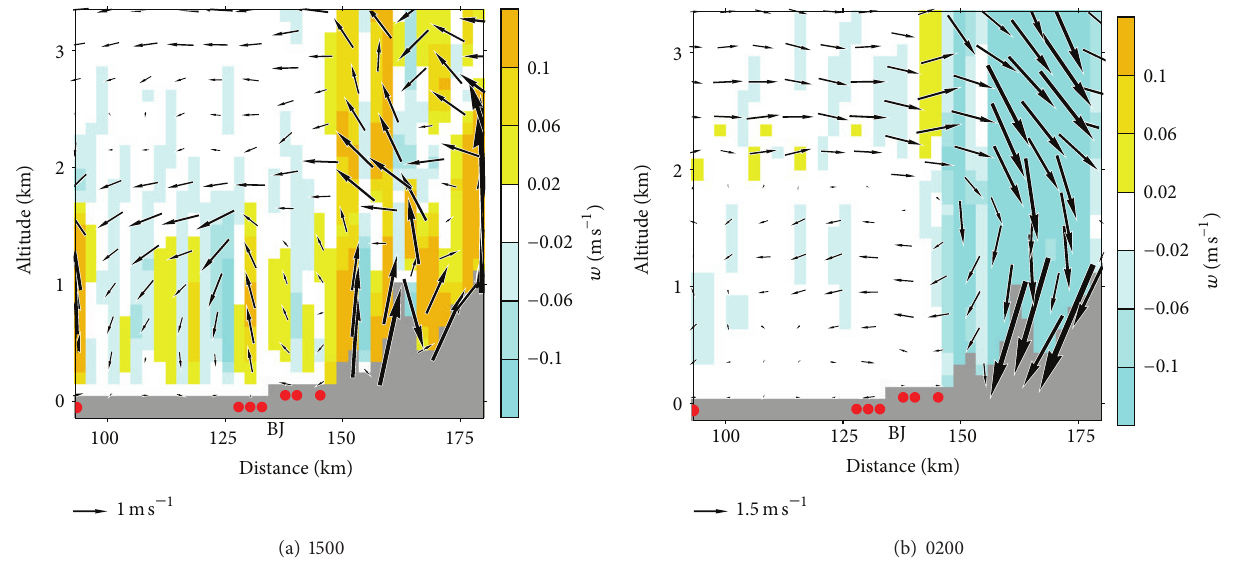
Figure 13: Vertical fields over Beijing in the CNTL experiment at (a) 1500LST 24 August and (b) 0200 LST 25 August. Please refer to Figure 6 for more details of the figure